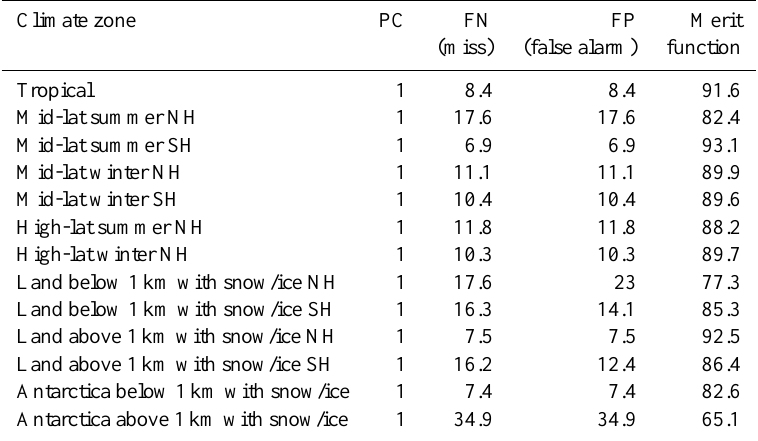
Table 5. CDA results based on coinciding training and validation data sets for daytime soundings over land. The percentage of hit or success (TP) and of correct non-events (TN) can be obtained by 100 − FP and 100 − FN, respectively.